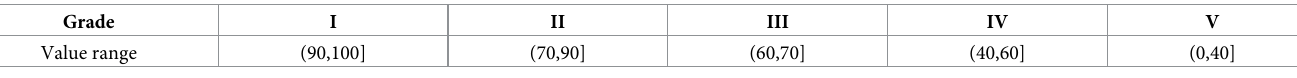
Table 2. Evaluation grades and value ranges for spontaneous goaf combustion. Grade